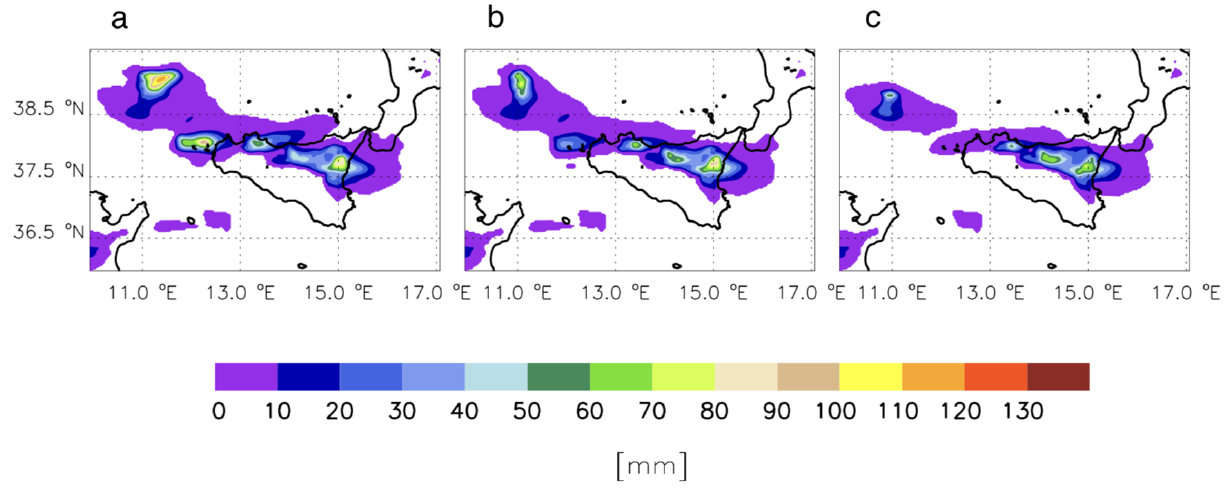
Figure 12. Rainfall forecast between 14:00 and 17:00 UTC on 15 July 2020 for simulations: ( a ) RL7.5h, ( b ) RL7.0h, ( c ) RL6.5h.